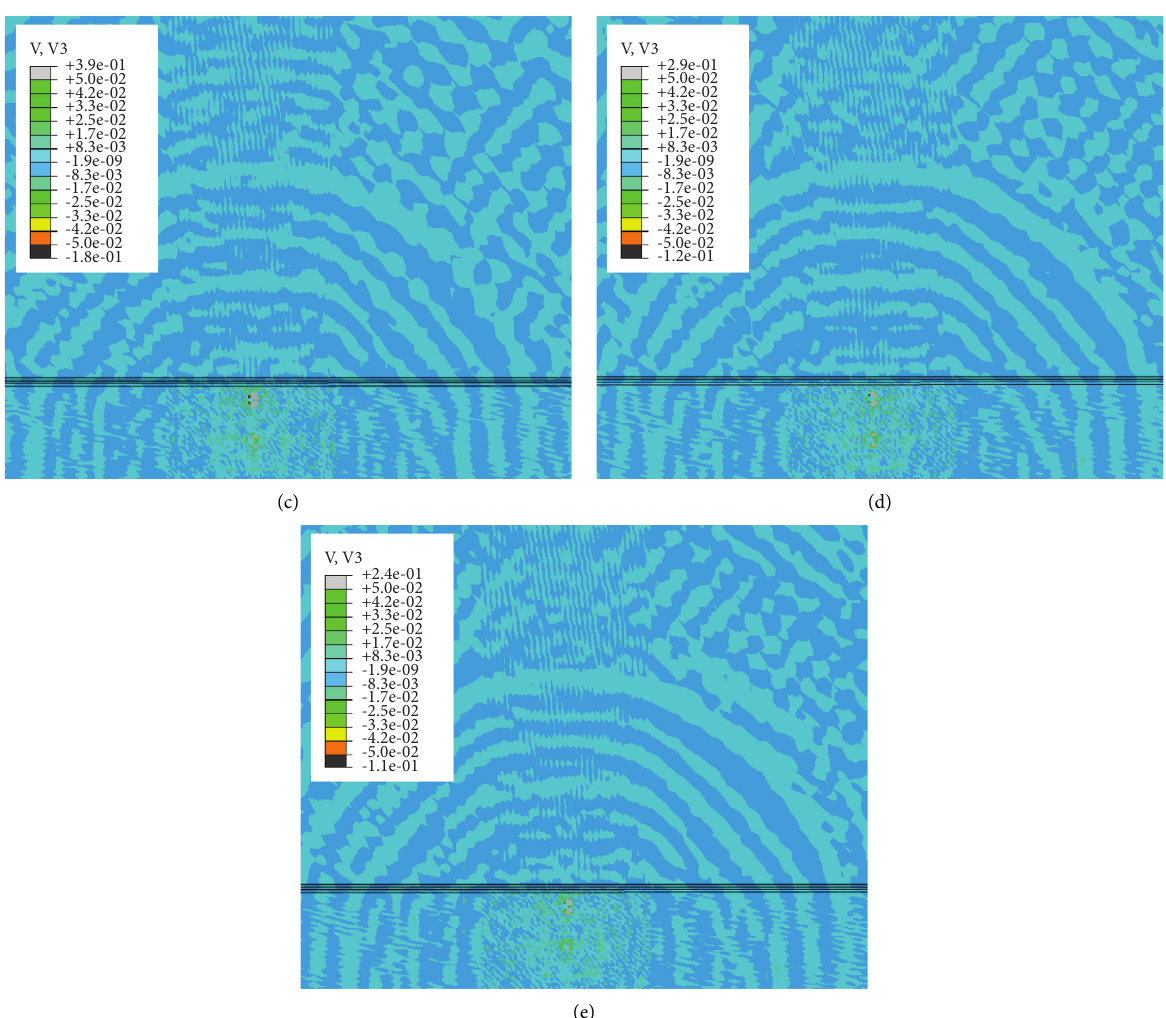
Figure 14: Cloud plots of the peak vertical vibration velocities at different measuring points with different time intervals (m/s; for the vertical arrangement): (a) 1s, (b) 3s, (c) 5s, (d) 8s, and (e)